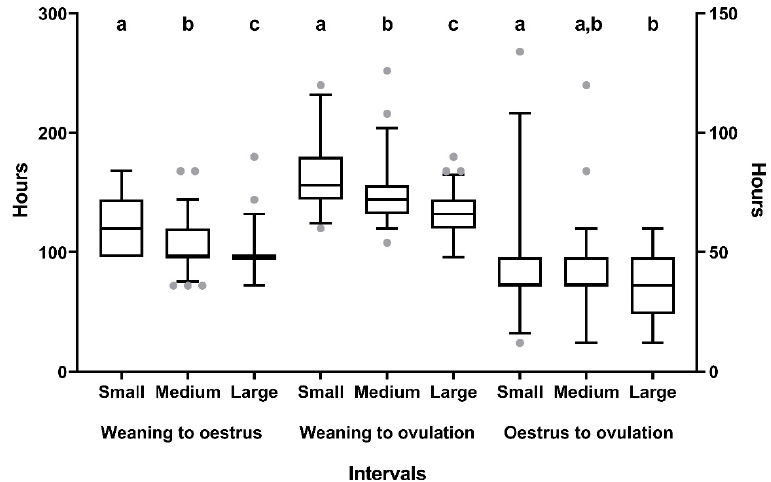
Figure 2. Box–whisker plots showing differences in the intervals between weaning and onset of estrus (left Y axis), weaning and ovulation (left Y axis) and the start of estrus and ovulation (right Y axis) among sows hierarchically grouped according to the mean ovarian follicle diameter at weaning: Small (0.20–0.30 cm), medium (0.31–0.39 cm), or large (0.40–1.00 cm). Boxes enclose the 25th and 75th percentiles; the line is the median; and the whiskers extend to the 5th and 95th percentiles. Grey dots show outliers. a, b, and c indicate significant differences ( p < 0.05).